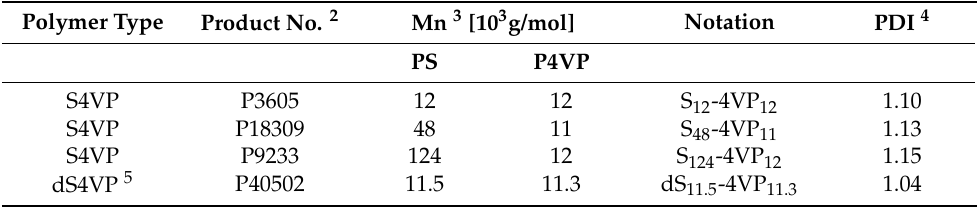
Table 2. Characteristics of the dispersing copolymers 1 . Polymer